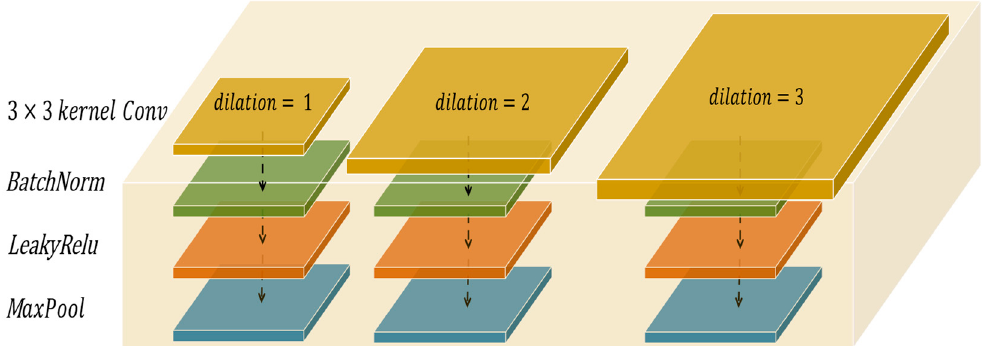
Figure 2. Multiscale convolutional layers.